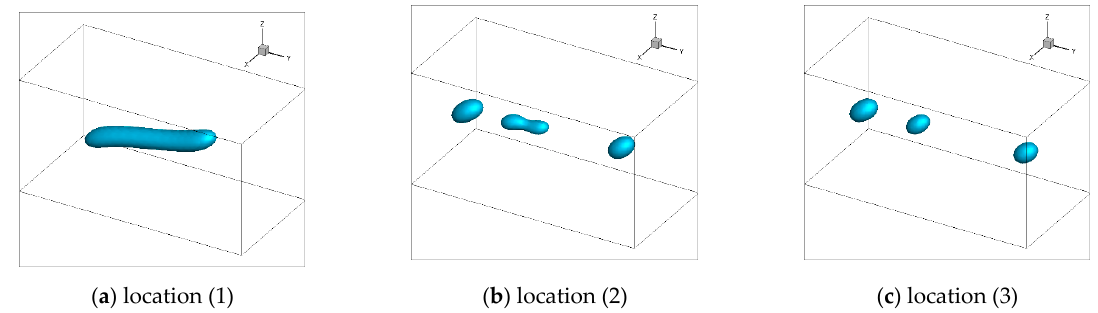
Figure 14. Simulated morphologies of droplet A under high injection rate.